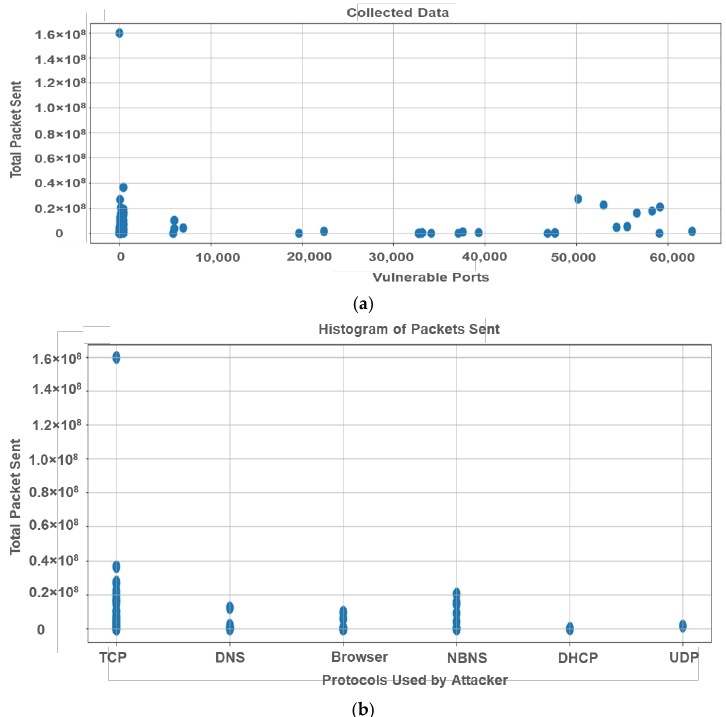
Figure 9. Histogram for ( a ) Total Packets sent vs. Vulnerable Ports, ( b ) Total Packets sent vs. Protocol used by Attackers. Figure 10 represents the histogram between the total data collected from each unique I.P., whole time spent on the network, and protocols used to attack the network. Figure 10a highlights the amount spent by the attacker for every Protocol used to attack the host. In Figure 10b, the data points for time spent are highlighted in blue, whereas the data points for total packets sent are highlighted in red. Even though these have different units, it gives us a statistical relative visual of how the time spent by the attacker varies concern- ing the number of packets sent for the same protocols used.